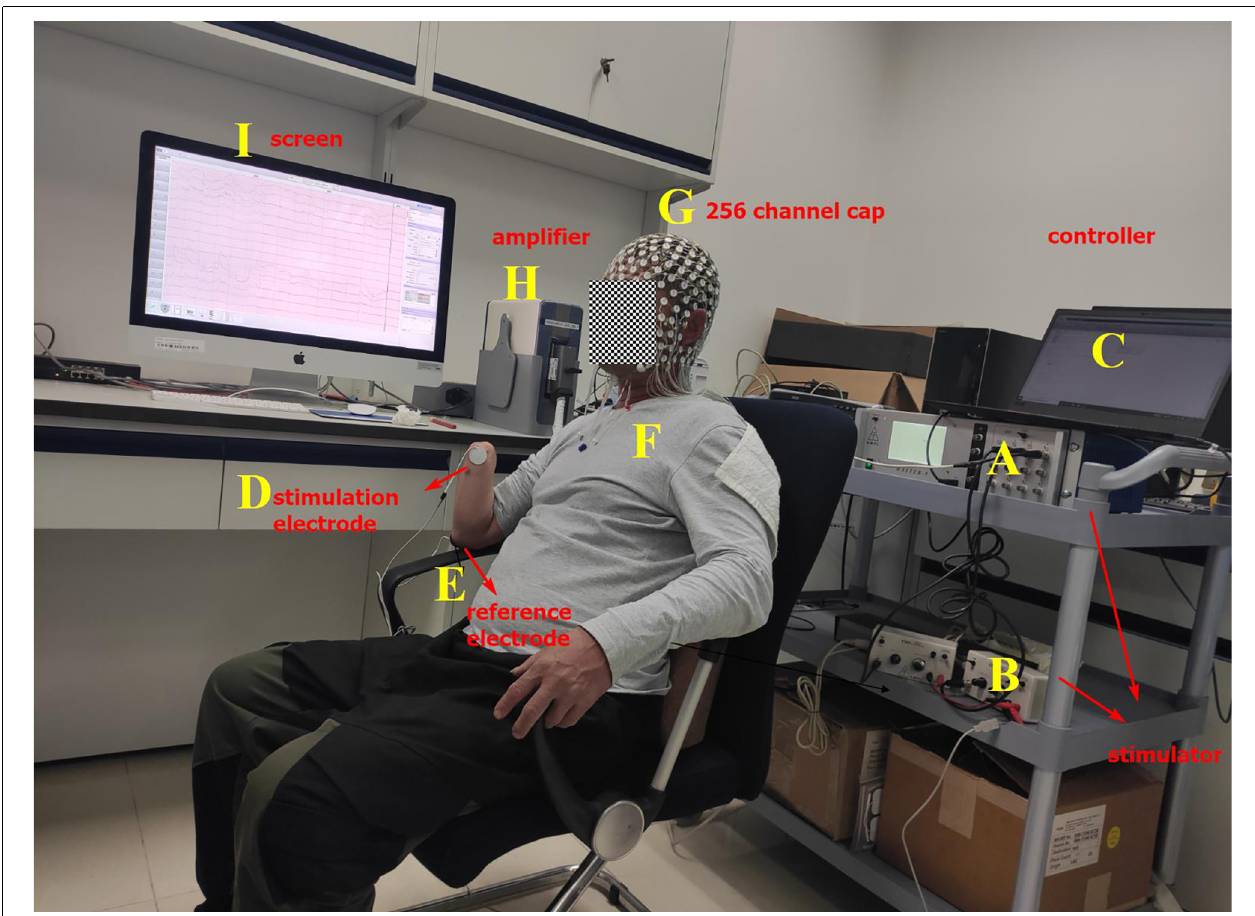
FIGURE 1 | Experimental platform. (A) Master-9, programmable electrical stimulation device. (B) Two isolators. (C) Computer. (D) Stimulation electrode that is glued to the projected finger map (PFM) region. (E) Reference electrode that is glued to the olecranon. (F) Amputee. (G) EEG cap with 256 channels. (H) EEG signal amplifier. (I)